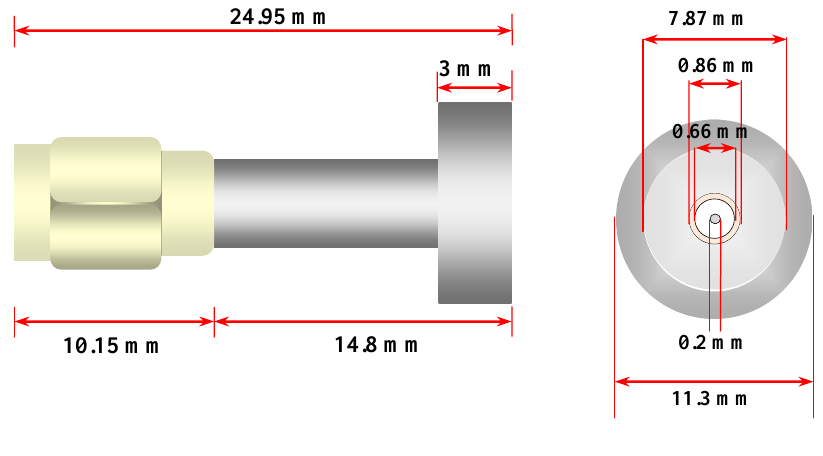
Figure 2. The Cross-sectional